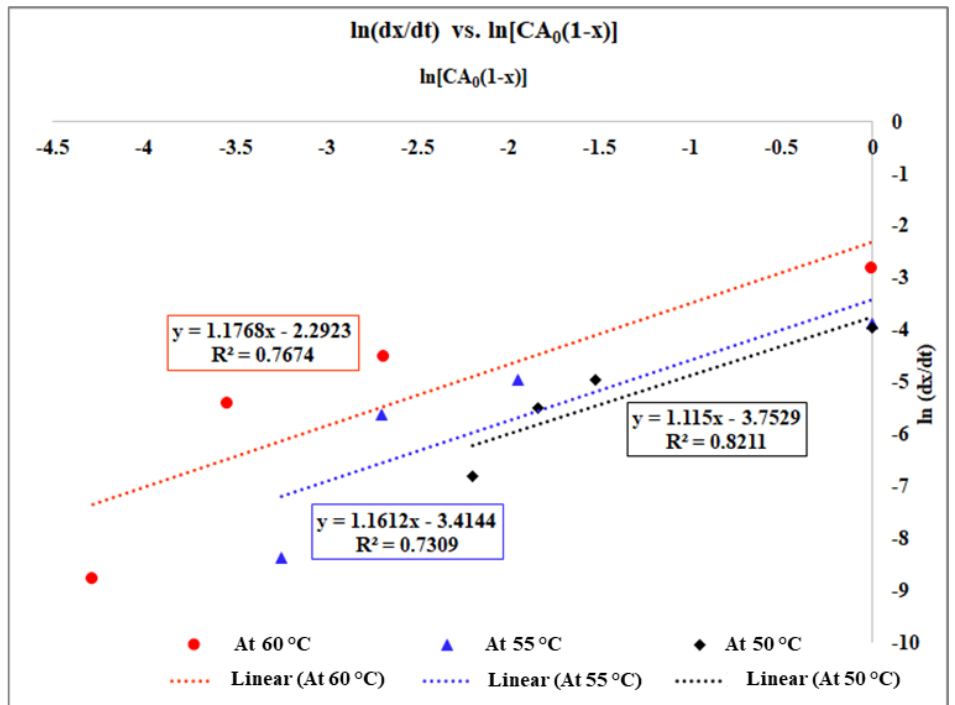
Figure 8. Determination of the reaction order and rate constants.